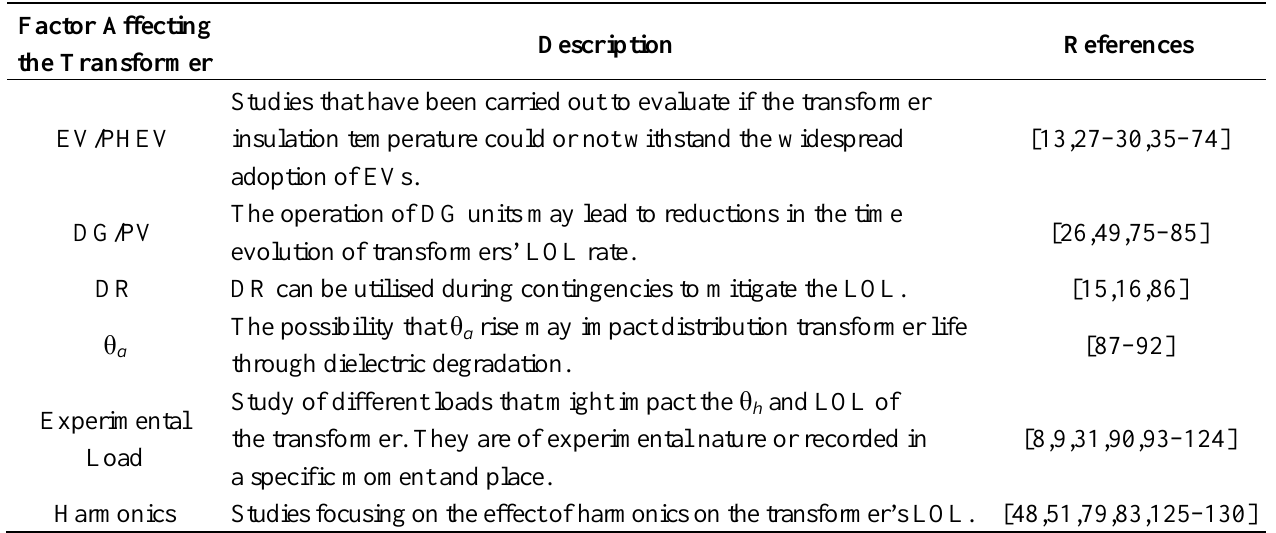
Table 1. Factors/Types of Load that influence the transformer loss-of-life (LOL). Factor Affecting the